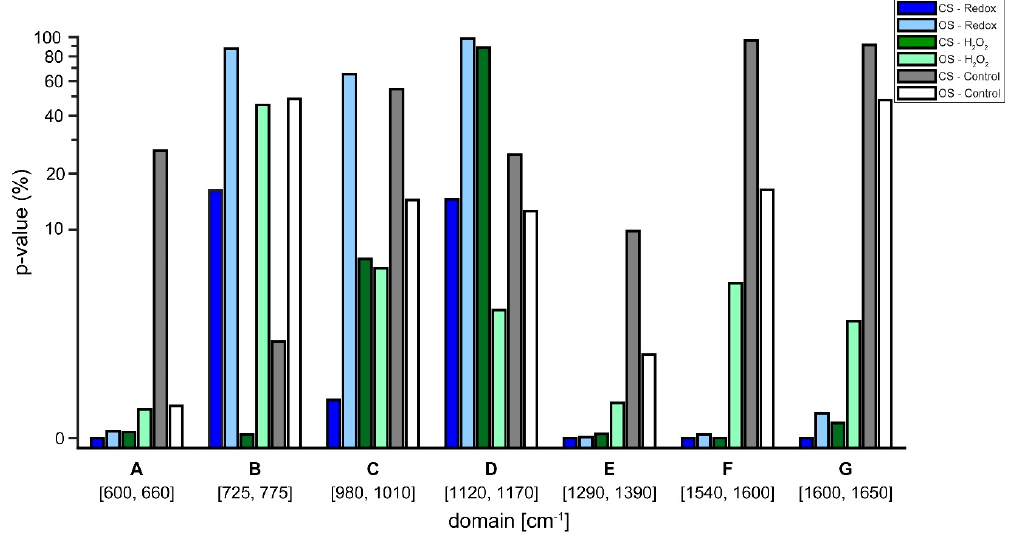
Figure 7. p -Values from closed system (CS) and open system (OS) for the spectral difference between normoxic and hypoxic conditions. p -values were computed in the seven domains ( A – G ) that contain Raman lines of the biomarkers (cytochromes, FeS or NADH).